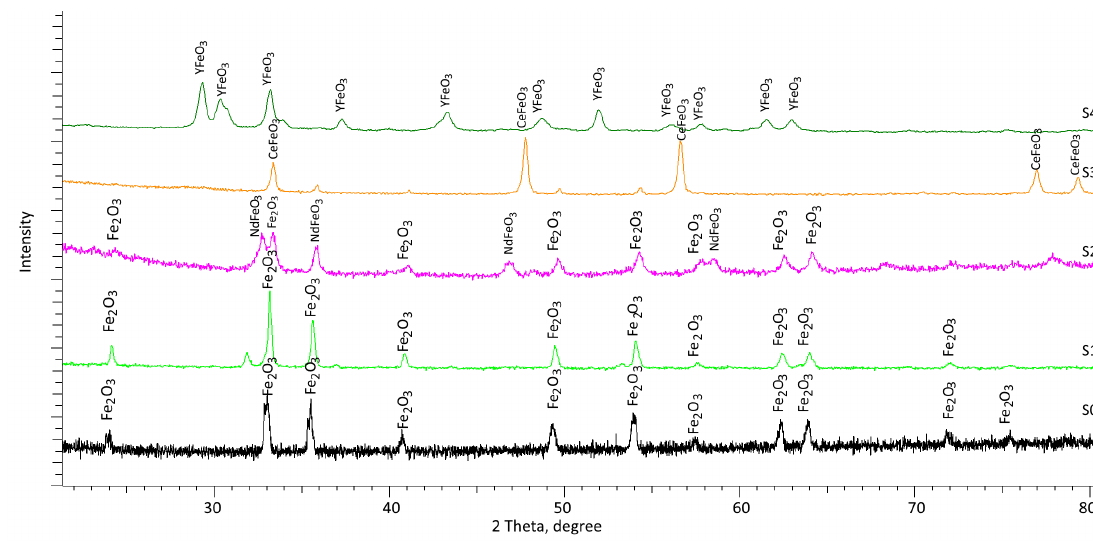
Figure 11. Diffractograms of samples after 10 days of corrosion testing.